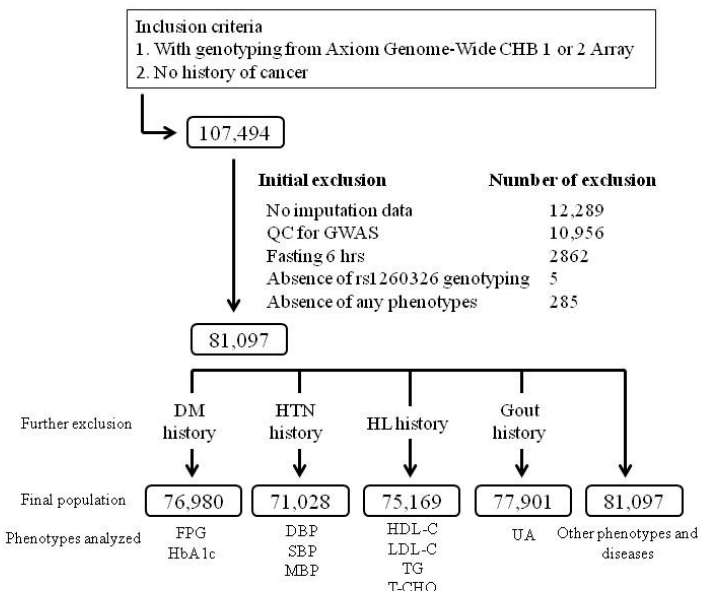
Figure 1. Study flowchart of inclusion and exclusion criteria used to screen Taiwan Biobank project participants. Other phenotypes include age; body mass index; waist circumference; waist–hip ratio; aspartate aminotransferase, alanine aminotransferase, γ -glutamyl transferase, and serum creatinine levels; estimated glomerular filtration rate; serum albumin; total bilirubin; hemoglobin; hematocrit; red blood cell, leukocyte, and platelet counts; and blood urea nitrogen, albuminuria, microalbuminuria, and metabolic syndrome. Abbreviations: QC, quality control; HL, hyperlipidemia; HTN, hypertension; DM, diabetes mellitus; HbA1C, hemoglobin A1C; SBP, systolic blood pressure; DBP, diastolic blood pressure; MBP, mean blood pressure; LDL-C, low-density lipoprotein cholesterol; HDL-C, high-density lipoprotein cholesterol; TG, triglyceride; T-CHO, total cholesterol; UA, uric acid.